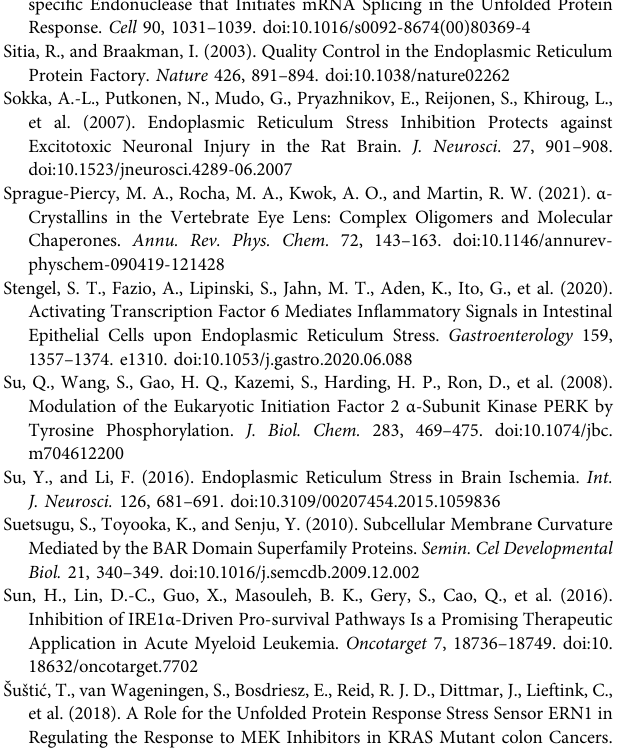
Tabas,I., and Ron,D.(2011).Integrating theMechanismsof Apoptosis Induced by Endoplasmic Reticulum Stress. Nat. Cel Biol 13, 184 – 190.